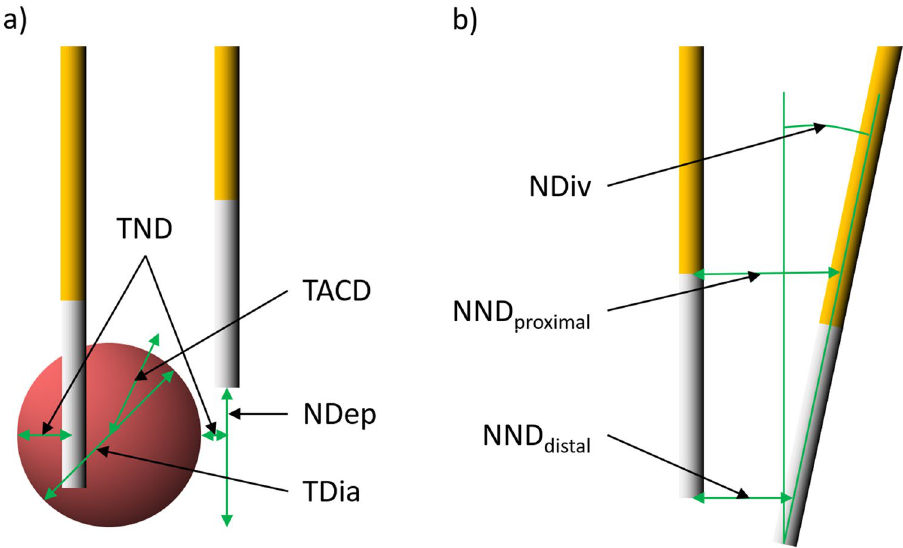
Figure 1. ( a ) Geometric parameters describing the relation of the needles to the lesion and ( b ) the position of the needles in relation to each other. The active needle tip is shown in white; the needle shaft is shown in orange. Please refer to the text for a detailed explanation of the parameters ( TND tumor-to-needle distance; TACD tumor-center-to-ablation-center distance; NDep needle depth; NDiv needle divergence; NND needle-to-needle distance; TDia tumor